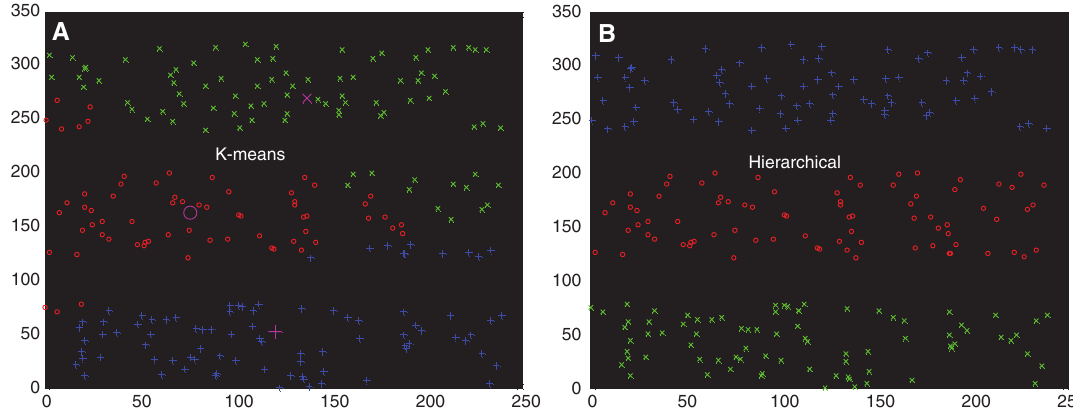
Figure 3: Clustering of zoned arrangement by (A) K-means and (B) hierarchical clustering approaches.